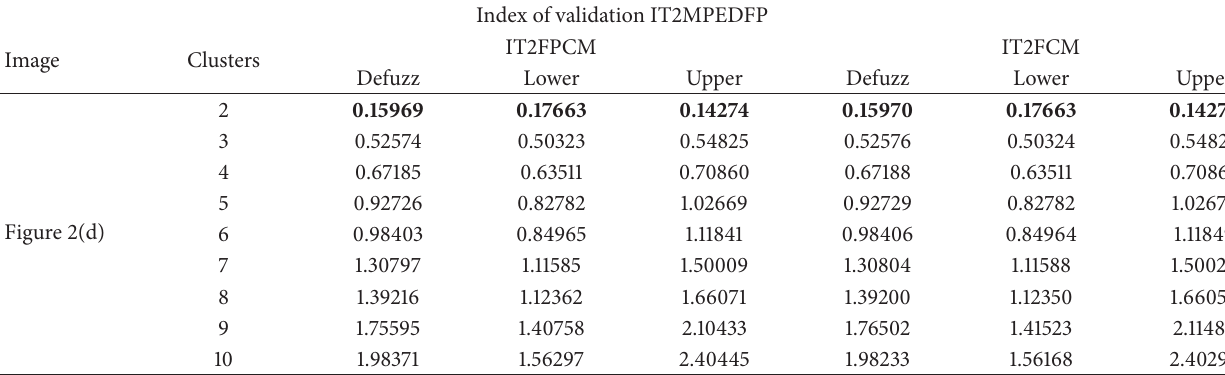
Table 37: Results of the IT2MPE-DMFP validation index to data clustering of image shown in Figure 2(d) using IT2FPCM and IT2FCM algorithm with 𝑚 = [1.5, 2.5] and 𝜂 = [1.5, 2.5] as